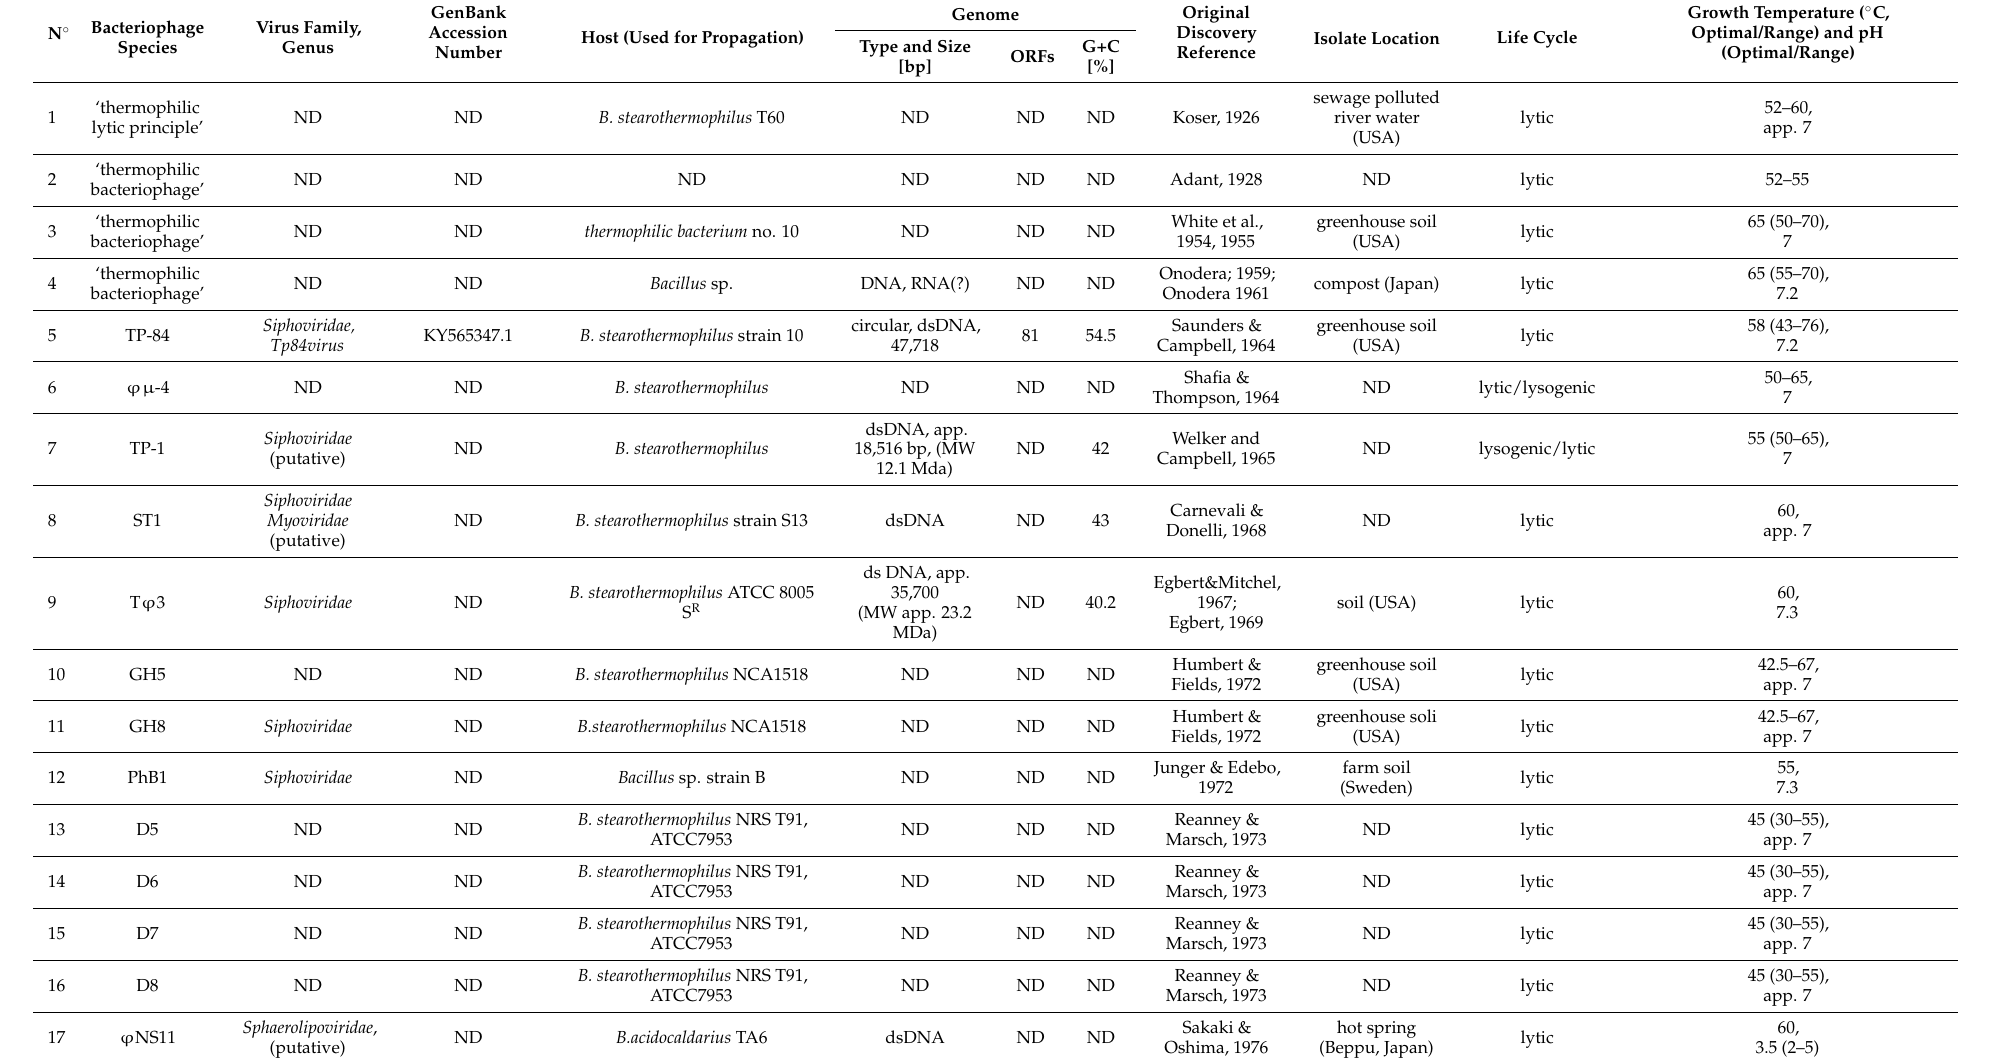
Table 2. Classification and major data describing ‘ Bacillus group’ thermophilic bacteriophages (chronologically as